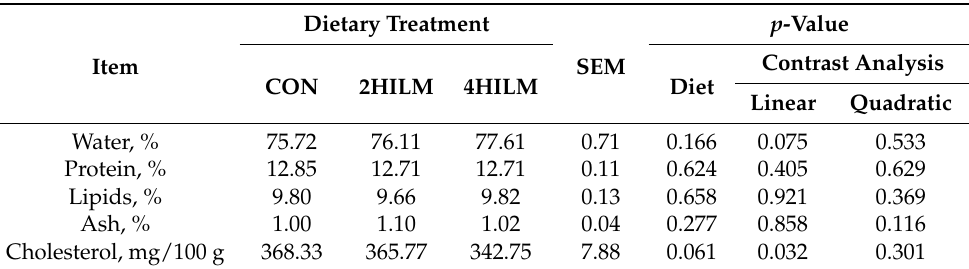
Table 6. Effects of the dietary Hermetia illucens larvae meal (HILM) inclusion level on the proximate composition and cholesterol content of